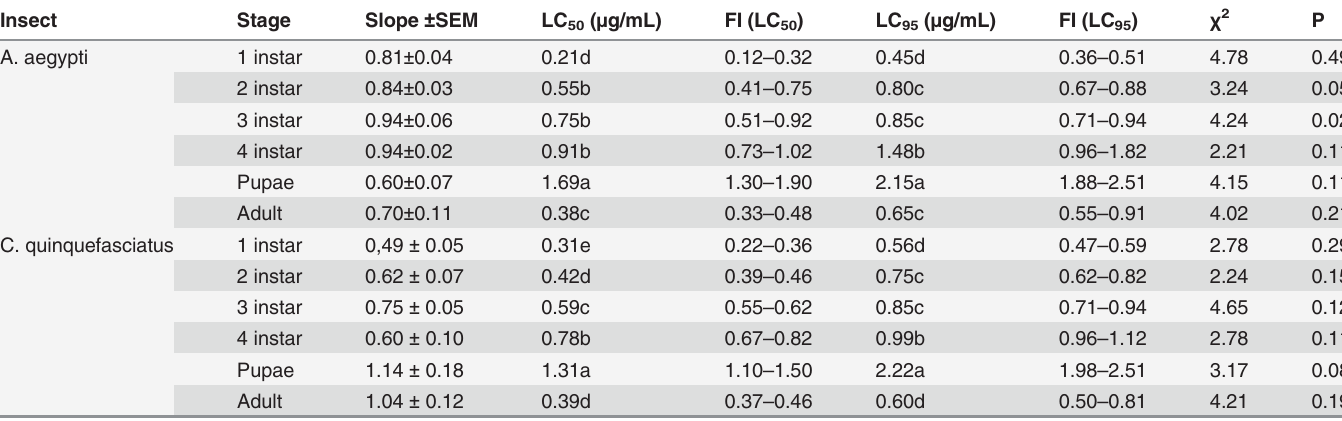
SEM = standard error of the mean; LC = lethal concentration ( µ L/mL); FI = fi ducial interval at 95% of probability; χ 2 = Chi squared. Means followed by different letters are signi fi cantly different (P < 0.05). Analysis of variance followed by Tukey ’ s